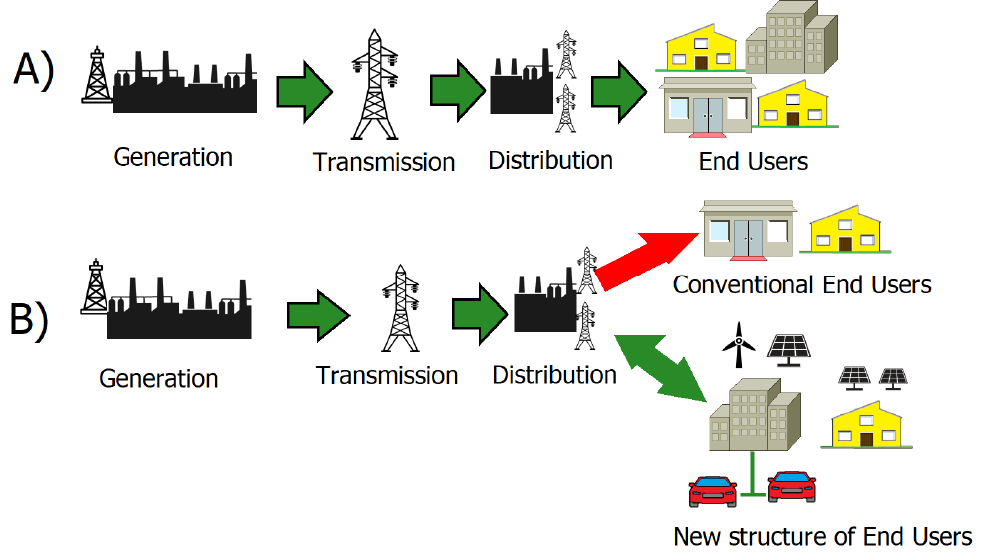
Fig. 1-A . The traditional scheme of electricity systems. B . The new scheme of generation and production of the electricity